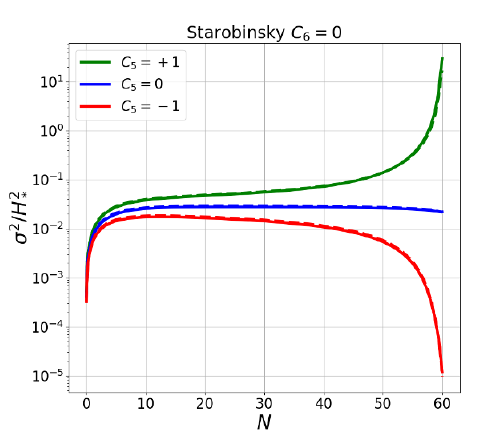
For each case the full versus dashed lines rep-